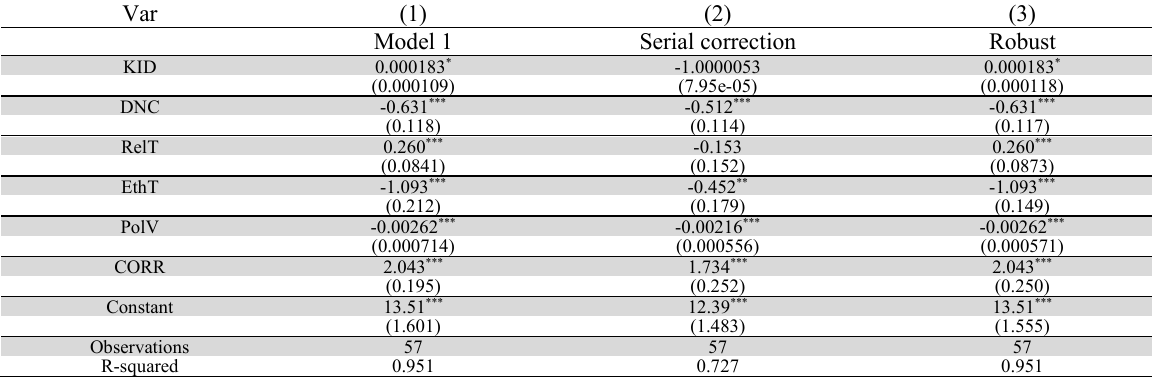
Results of Estimation for FDI and Political Risk